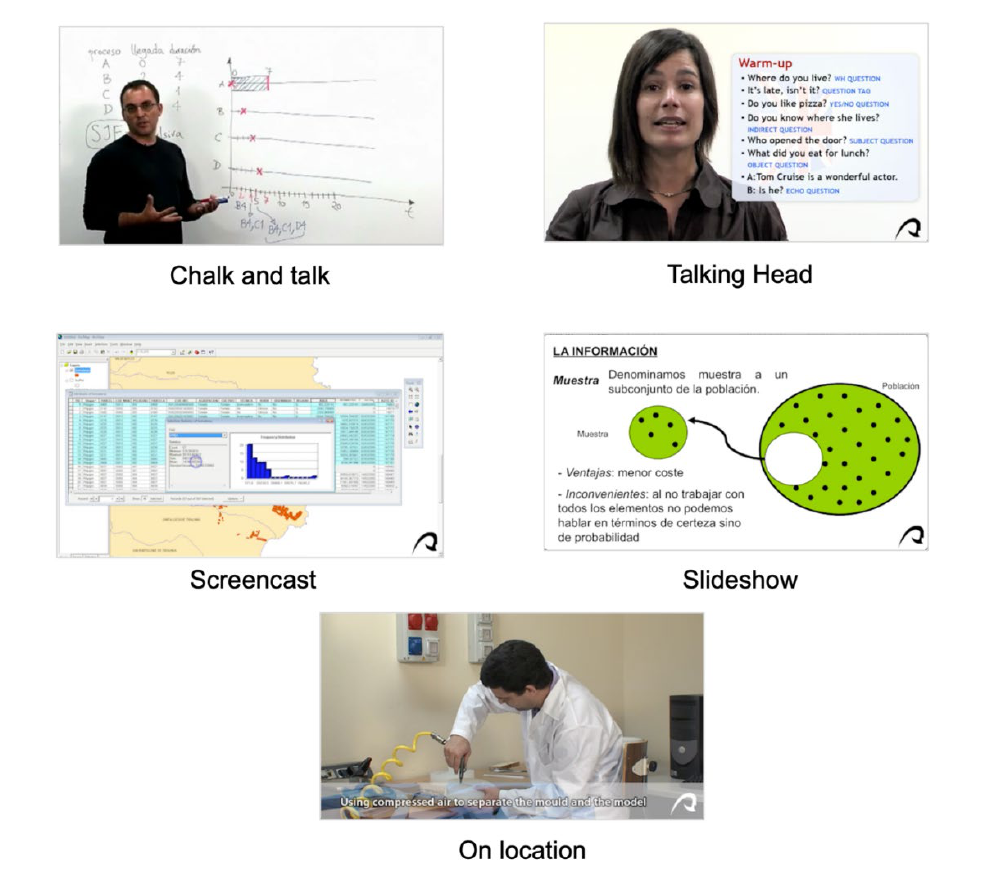
Screenshots of the Prometeo Project’s Main Production